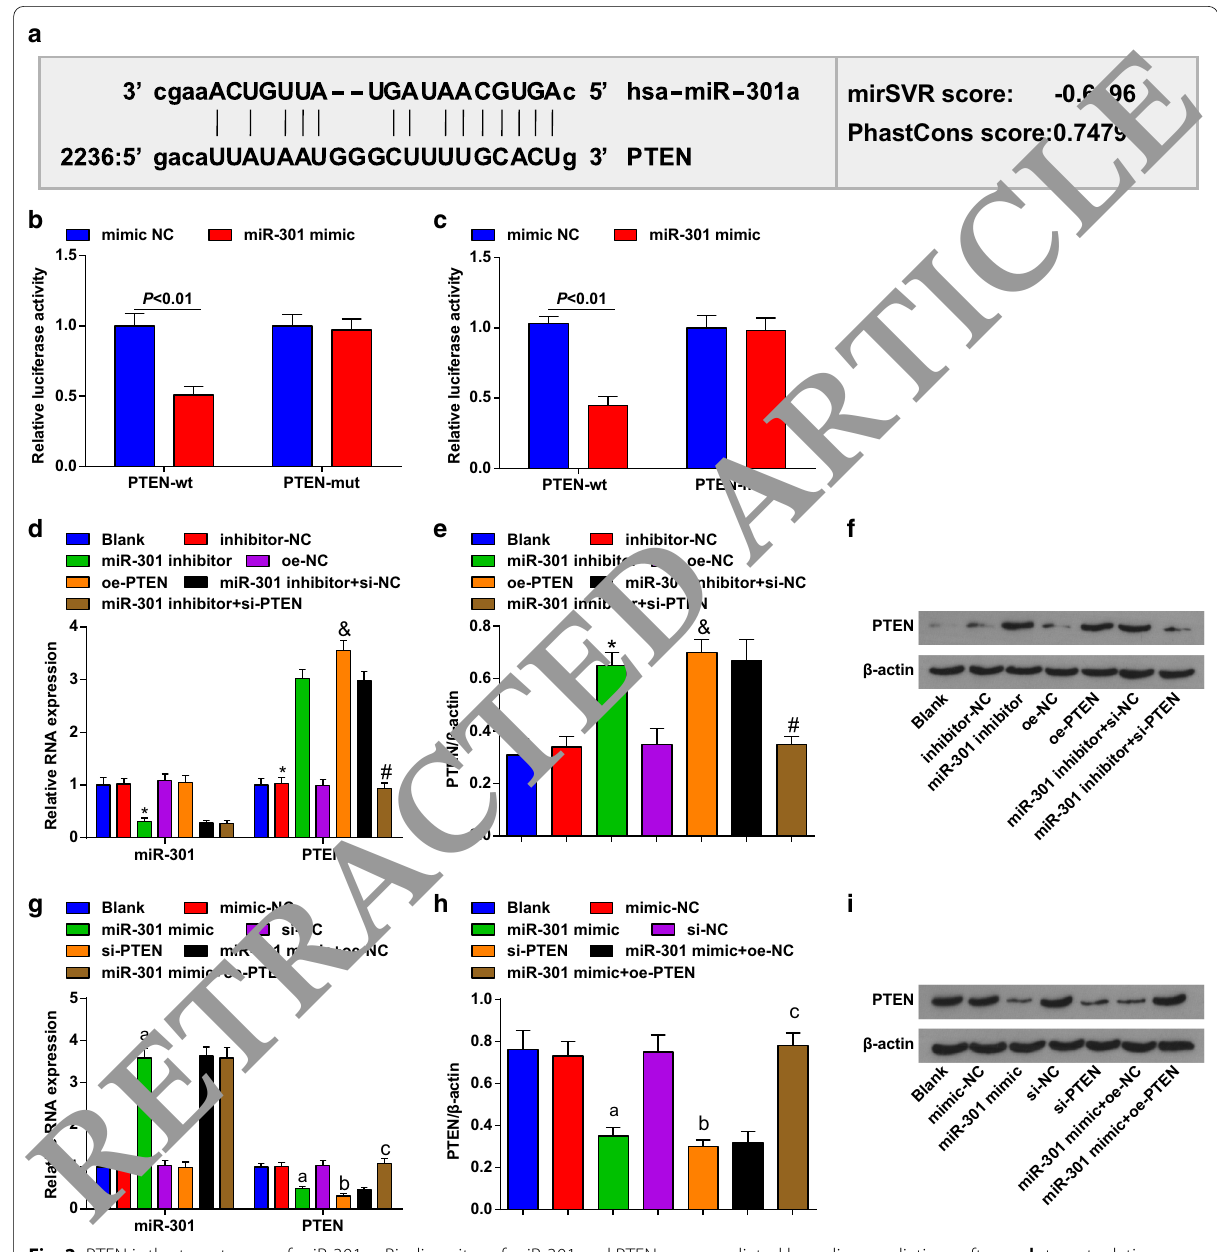
Fig. 2 PTEN is the target gene of miR-301. a Binding sites of miR-301 and PTEN were predicted by online prediction software; b target relation between miR-301 and PTEN in KYSE-30 cells was assessed by dual luciferase reporter gene assay; c target relation between miR-301 and PTEN in Eca109 cells was assessed by dual luciferase reporter gene assay; d expression of miR-301 and PTEN mRNA expression in KYSE-30 cells detected using RT-qPCR after miR-310 downregulation or PTEN upregulation; e protein expression of PTEN in KYSE-30 cells detected using Western blot analysis after miR-310 downregulation or PTEN upregulation; f protein bands of PTEN in KYSE-30 cells in Western blot analysis after miR-310 downregulation or PTEN upregulation; g expression of miR-301 and mRNA expression of PTEN in Eca109 cells detected using RT-qPCR after miR-310 upregulation or PTEN downregulation; h protein expression of PTEN in Eca109 cells detected using Western blot analysis after miR-310 upregulation or PTEN downregulation; i protein bands of PTEN in Eca109 cells in Western blot analysis after miR-310 upregulation or PTEN downregulation. * P < 0.05 versus the inhibitor-NC group, & P < 0.05 versus the oe-NC group, # P < 0.05 versus the miR-301 inhibitor the mimic-NC group, b P < 0.05 versus the si-NC group, c P < 0.05 versus the miR-301 mimic mean standard deviation, and the t test was performed for comparisons between two groups. ANOVA was used for comparisons among multiple ±